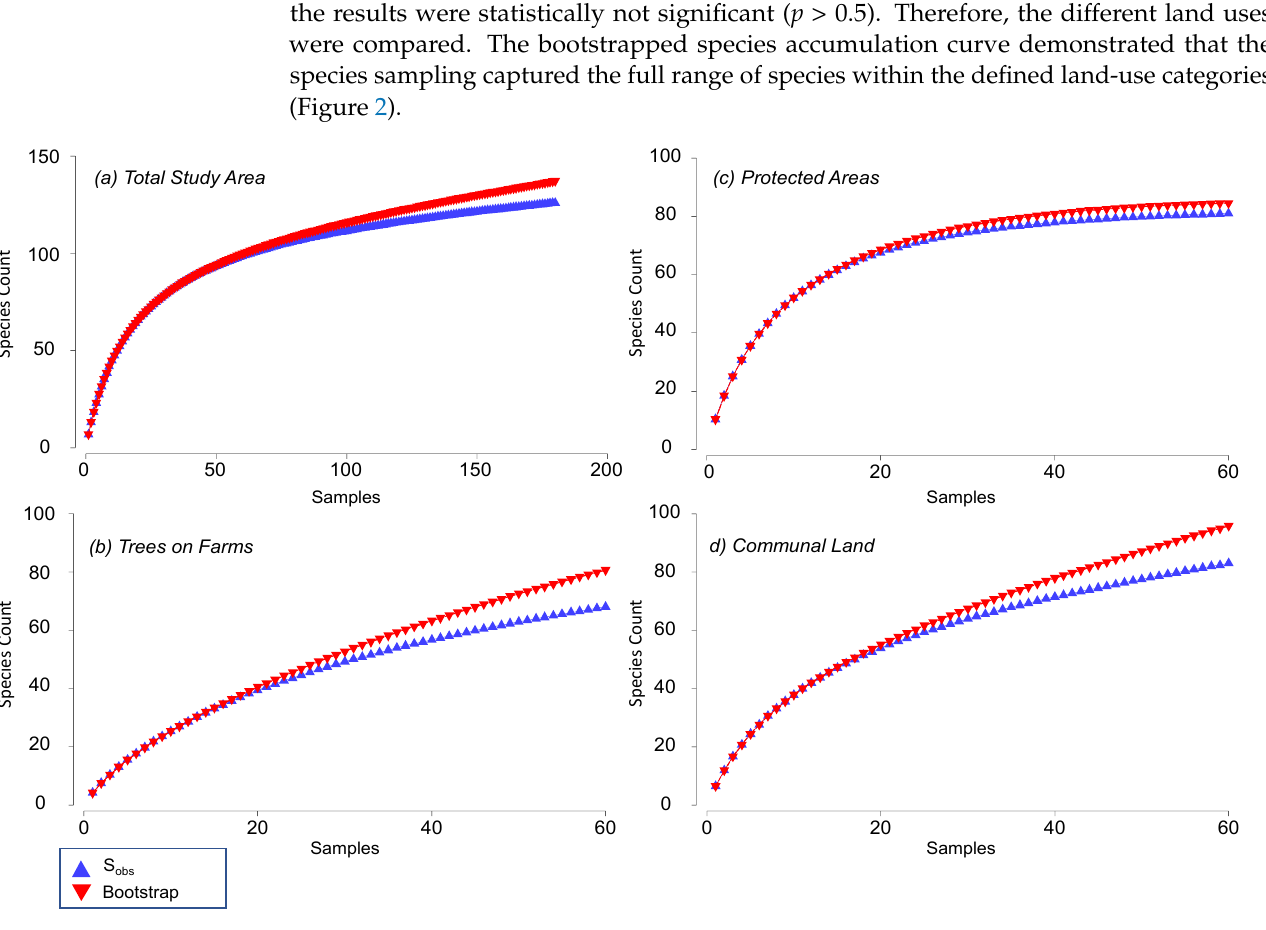
Figure 2. Estimation of actual (S Ob ) and estimated (Bootstrap) total species richness for ( a ) the total study area, ( b ) Trees on farms, ( c ) Protected areas, ( d ) Communal Land.